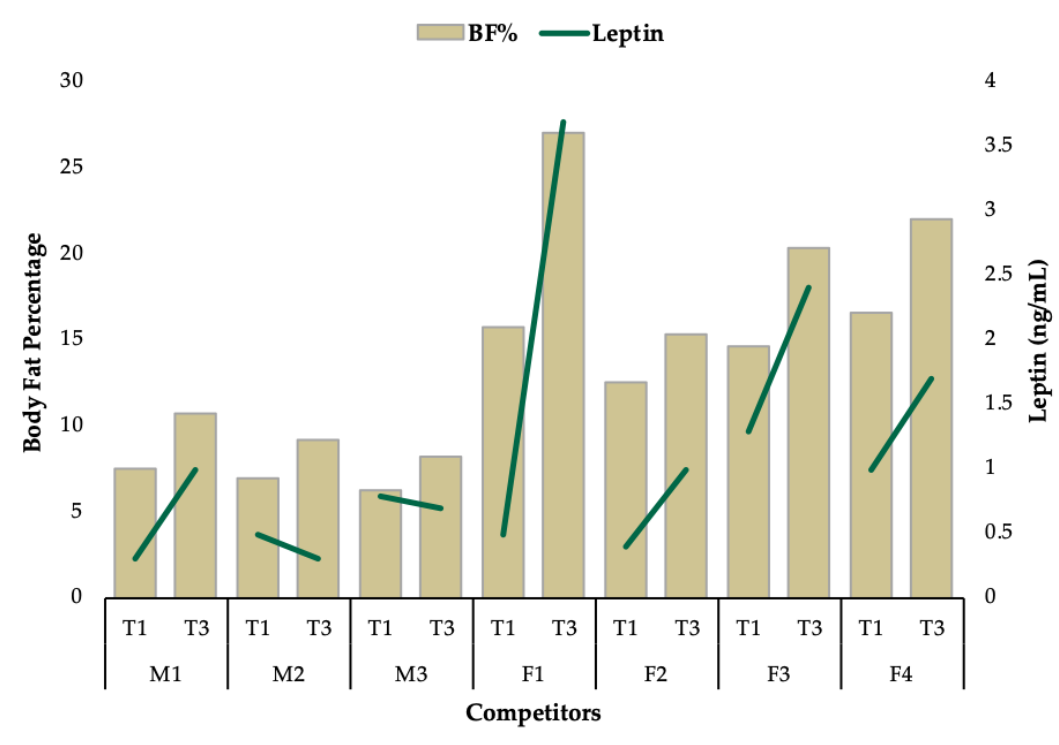
Figure 3. Changes in body fat percentage and leptin from T1 to T3.